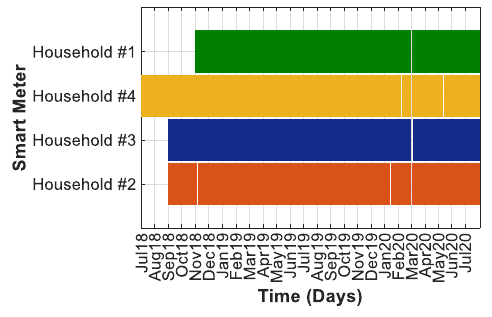
Figure 5. Data availability for every household.